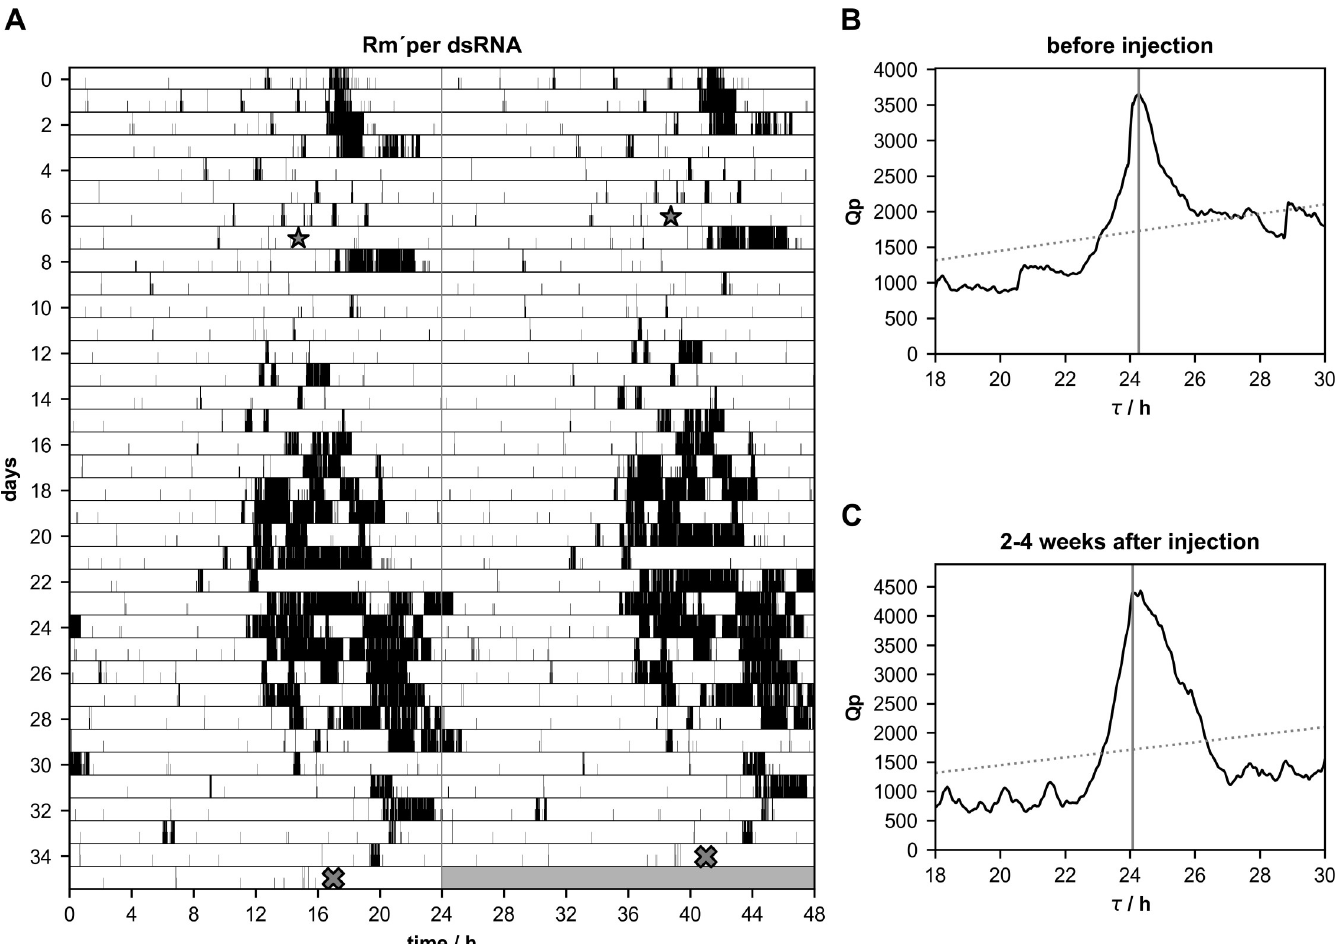
Fig 3. A-C. After injections of Rm´per dsRNA circadian rhythmicity of running wheel activity remained synchronized with almost unchanged period ( τ )in only one Madeira cockroach (n = 1 of 12). (A) Double-plotted running wheel activity rhythm of a Madeira cockroach in constant darkness one week before, and 28 days after the injection of Rm´per dsRNA (star). At day 35 of the locomotor activity recording the cockroach was sacrificed (cross) and qPCR was used to confirm the knockdown. Chi-square periodogram analysis of the number of running wheel turns indicated significant rhythmicity with a period of 24.27 h 1–7 days before Rm´per dsRNA injection (B) and 24.08 h 2–4 weeks after the injection (C)